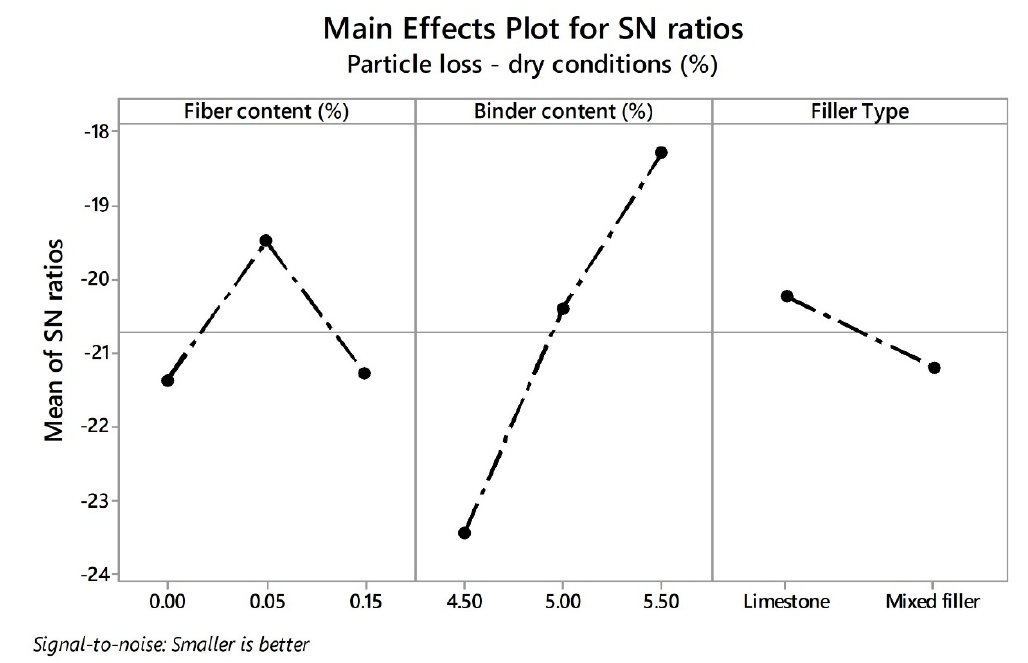
Materials 2020 , 13 , 675 Figure 10. E ff ects of parameters on mean SN ratios for PL dry . Figure 10. Effects of parameters on mean SN ratios for (cid:1842)(cid:1838) (cid:3031)(cid:3045)(cid:3052) .